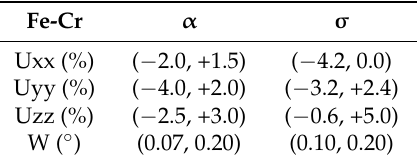
Table 1. In-grain strains (min, max) and peak broadening (min, max) in alpha and sigma phases extracted from Laue patterns. Uxx, Uyy, and Uzz are the macrostrains corresponding to the (001), (011), and (111) directions respectively (see Figure 2). Peak broadening W is given for grains indexed with at least seven Laue